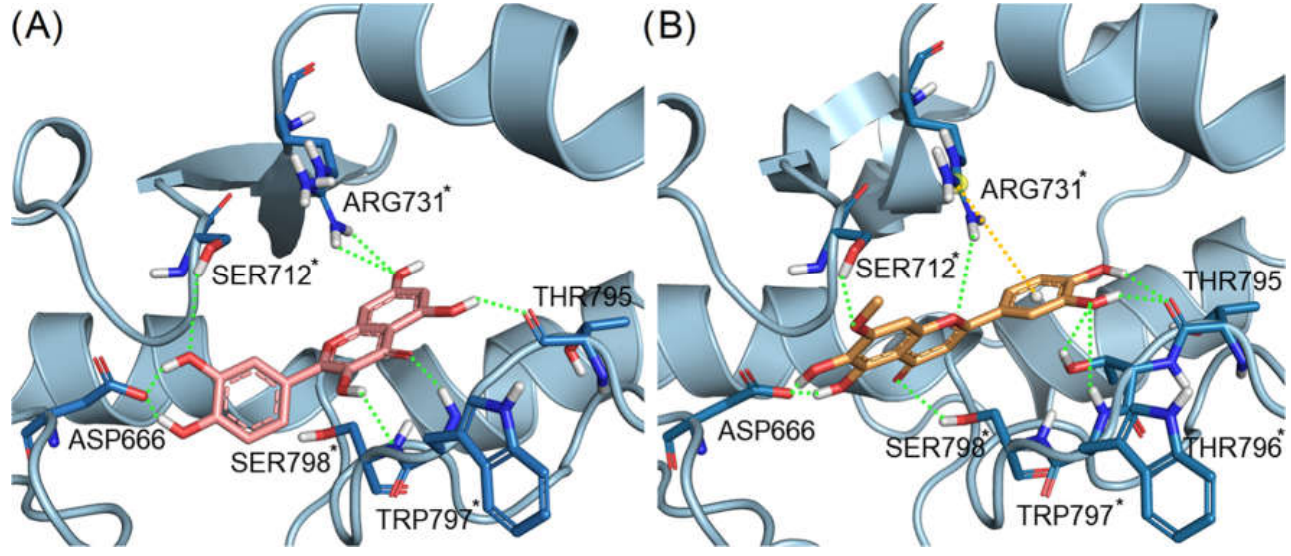
Figure 5. Docking poses of ( A ) quercetin (carbon atoms in pink sticks representation) and ( B ) pedalitin (carbon atoms in orange sticks) at the N -pocket of ZIKV RdRp. Hydrogen bonds are represented as green dotted lines and cation–π interactions in yellow dotted lines. The interactions of residues highlighted with an asterisk (*) are the same observed with the co-crystallized ligand. The binding modes of the flavonoids quercetin and pedalitin predicted by docking with ZIKV RdRp suggested a promising binding affinity with the allosteric binding site of the protein, corroborating the enzymatic assays